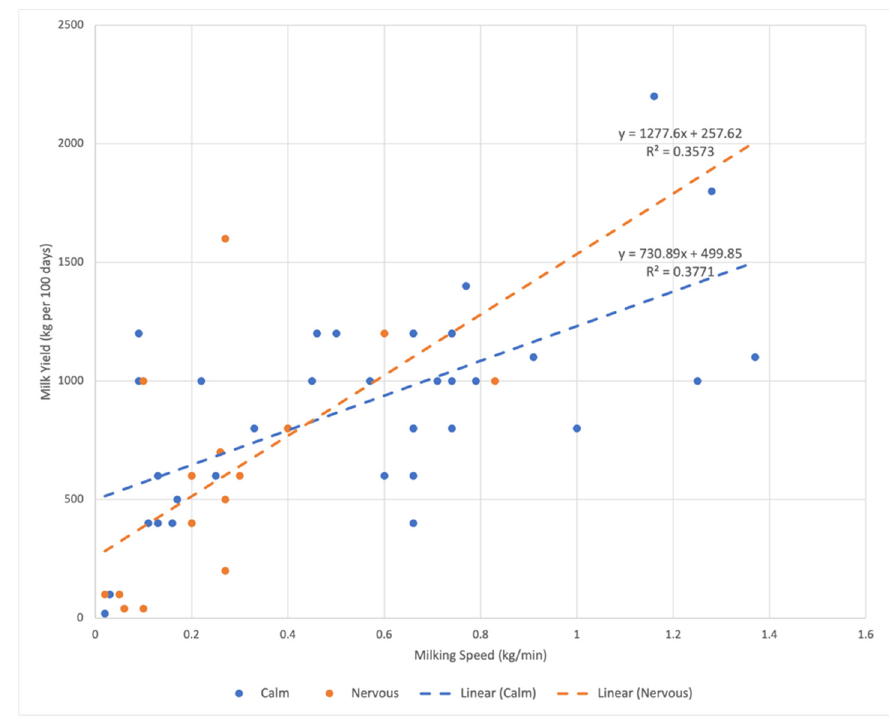
Figure 2. Linear regression models for the dependency between milk yield and milking speed.